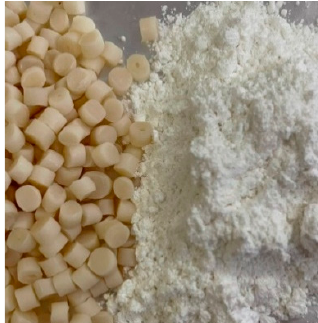
Figure 1. Two forms of Polyhydroxybutyrate (PHB): pellets (on the left) and fine powder (on the